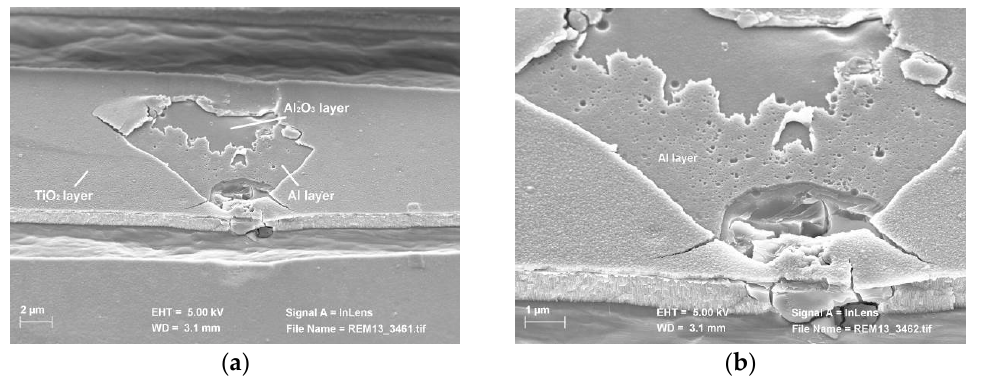
Figure 5. SEM image of micropitting corrosion in the Al layer of the same spot at two magnifications, 2 µm ( a ) and 1 µm ( b ).